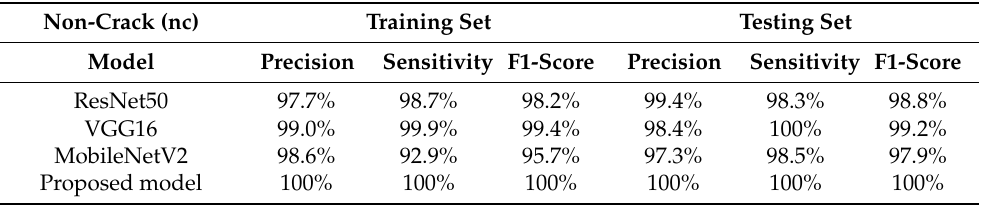
Table 5. Overall precision, sensitivity, and F1-Score of the non-crack concrete. Non-Crack (nc)